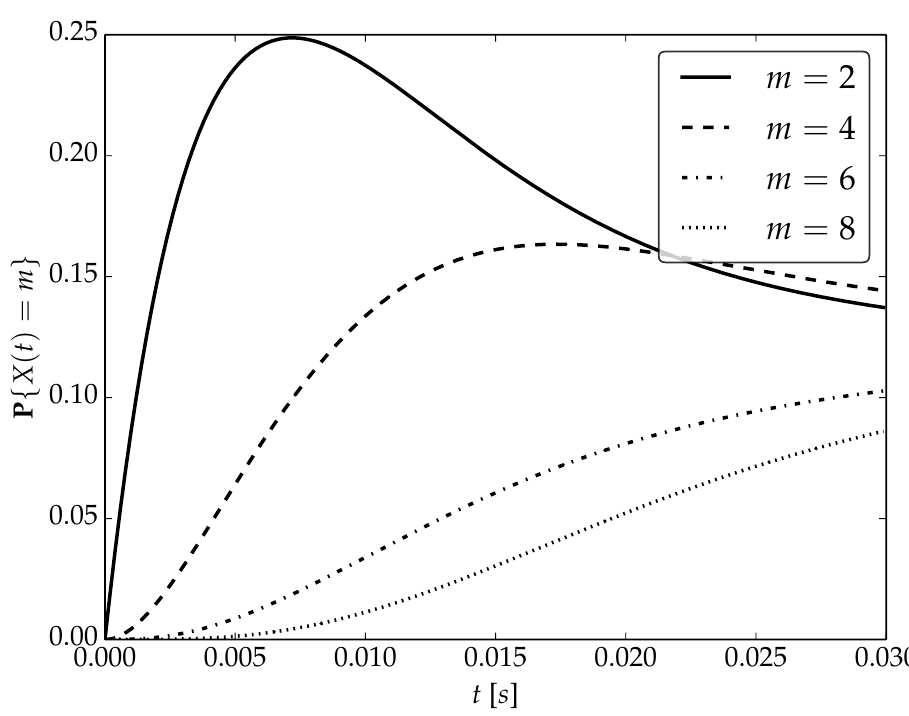
Figure 6. Transient distributions P { X ( t ) = m } for N = 4, batch distribution P 1 and ρ = 1.